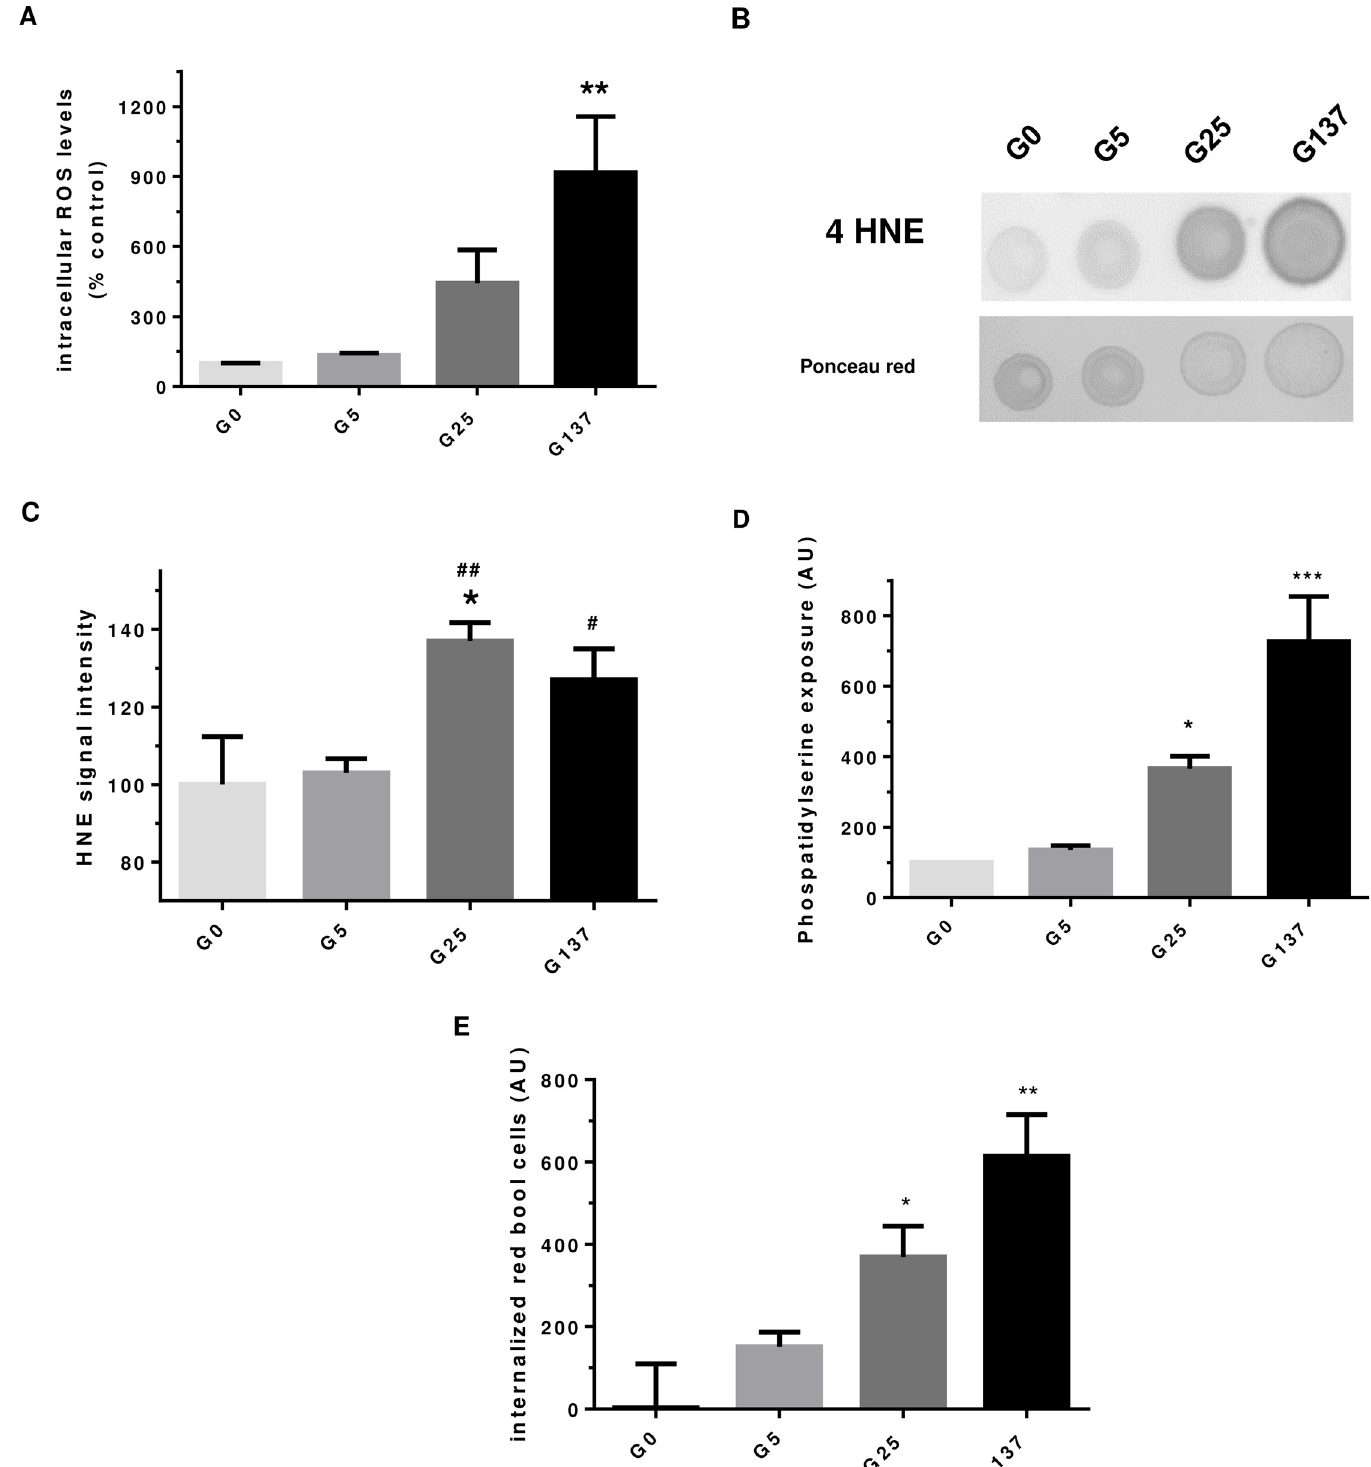
Fig 4. Enhanced oxidative stress and damages in glycated erythrocytes. In this figure, G0, G5, G25 and G137 represent the four conditions of incubation to which erythrocytes were subjected: 0, 5, 25 and 137 mmol/l glucose, respectively. (A) Intracellular ROS formation levels in erythrocyte preparation was determined using DHE probe by cytometry. Results are expressed as mean ± SEM (n = 4), �� p < 0.01 indicates a significant difference vs . G0 (one way ANOVA followed by Dunnet’s test). (B) 4-HNE dot blot image is representative of four dot blot experiments. (C) 4-HNE signal quantification was expressed as mean ± SEM (n = 4), � p < 0.05 ( vs . G0), # p < 0.05,